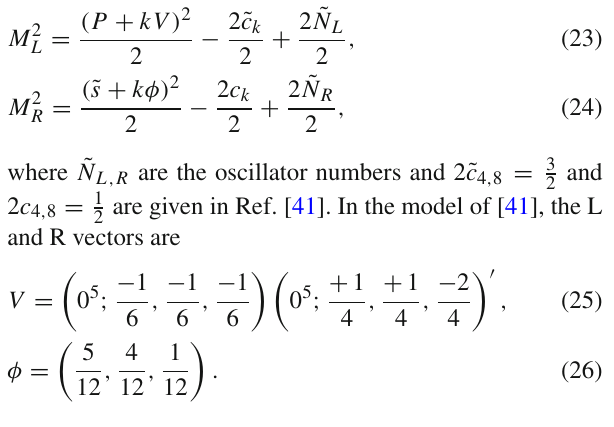
The QCD-color field in 5 + 2 finds the partner in 10 − 1 , both of which are shown in red in Fig. 2. Similarly, 5 − 2 finds the partner in 10 + 1 . Thus there remain only massless Higgs doublets from Eq. (20), H u and H d . The doublet– triplet splitting is realized. One pair of 5 − 2 and 5 + 2 needs one pair of 10 + 1 and 10 − 1 for the splitting. In view of the longevity of proton, note that the dangerous 10 H · 10 · 10 · 5 and 10 H · 5 · 5 · 1 couplings are allowed